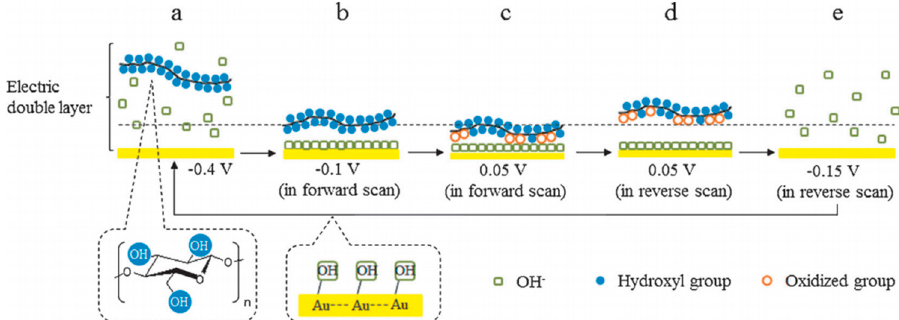
Figure 4. Proposed cellulose oxidation mechanism on electrode surface in alkali media in CV cycle. ( a ) initial state, with cellulose dissolved in alkali solution. ( b ) in forward scan region: adsorption of OH − ions to surface of electrode, cellulose molecule approaches OH-Au active sites. ( c ) oxidation of cellulose at electrode. ( d ) in reverse scan region: desorption of oxidation product and further oxidation of cellulose at revealed electrode surface. ( e ) desorption of OH − ions from electrode surface. Reprinted with permission from Ref. [35]. Copyright 2014, ChemSusChem.